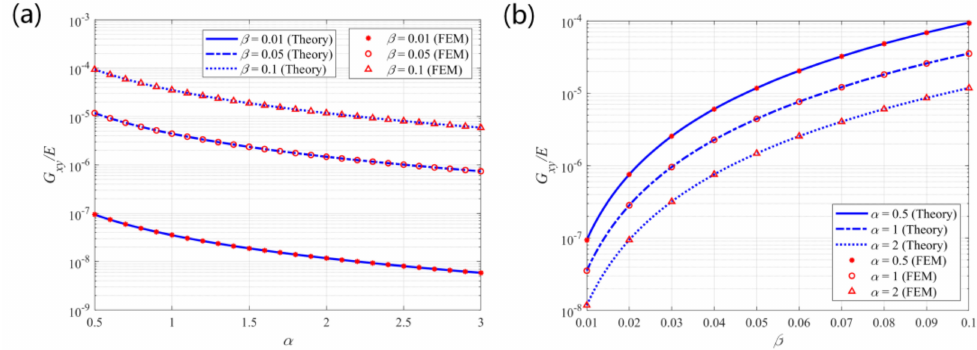
Figure 9. Theoretical predictions and finite element results for the effective shear modulus G xy /E vs. ( a ) α and ( b ) β